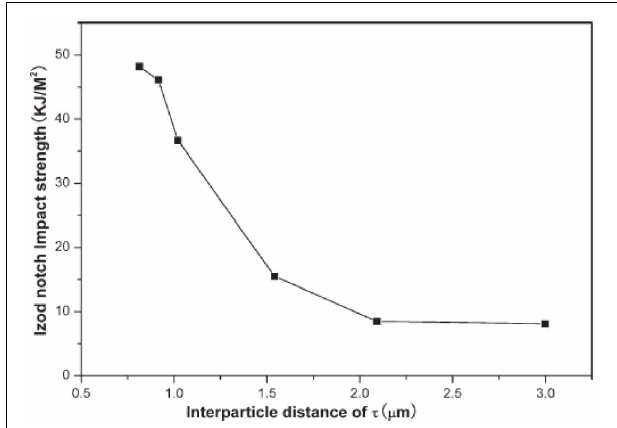
FIGURE 8 | The impact strength as a function of inter-particle distance of GMS. Copyright (2012) Wiley; used with permission from Ge et al. (2013).